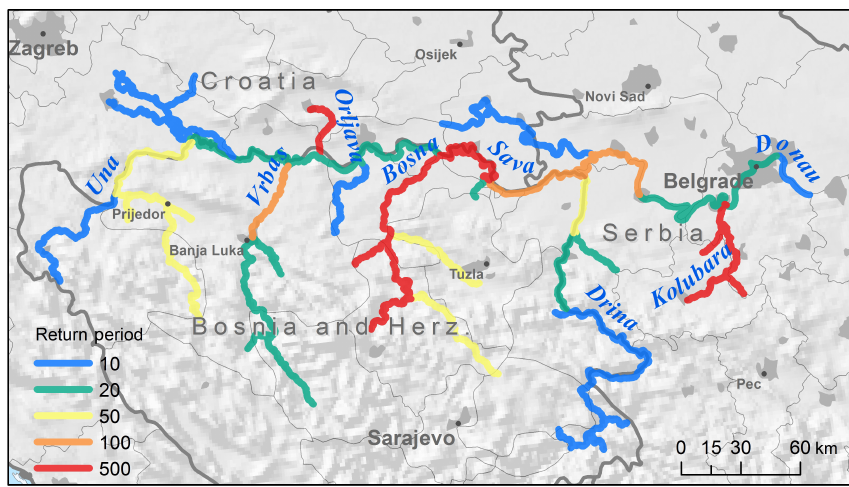
Figure 3. Reconstruction of return period of peak discharges in Sava River basin (source: ICPDR and ISRBC,